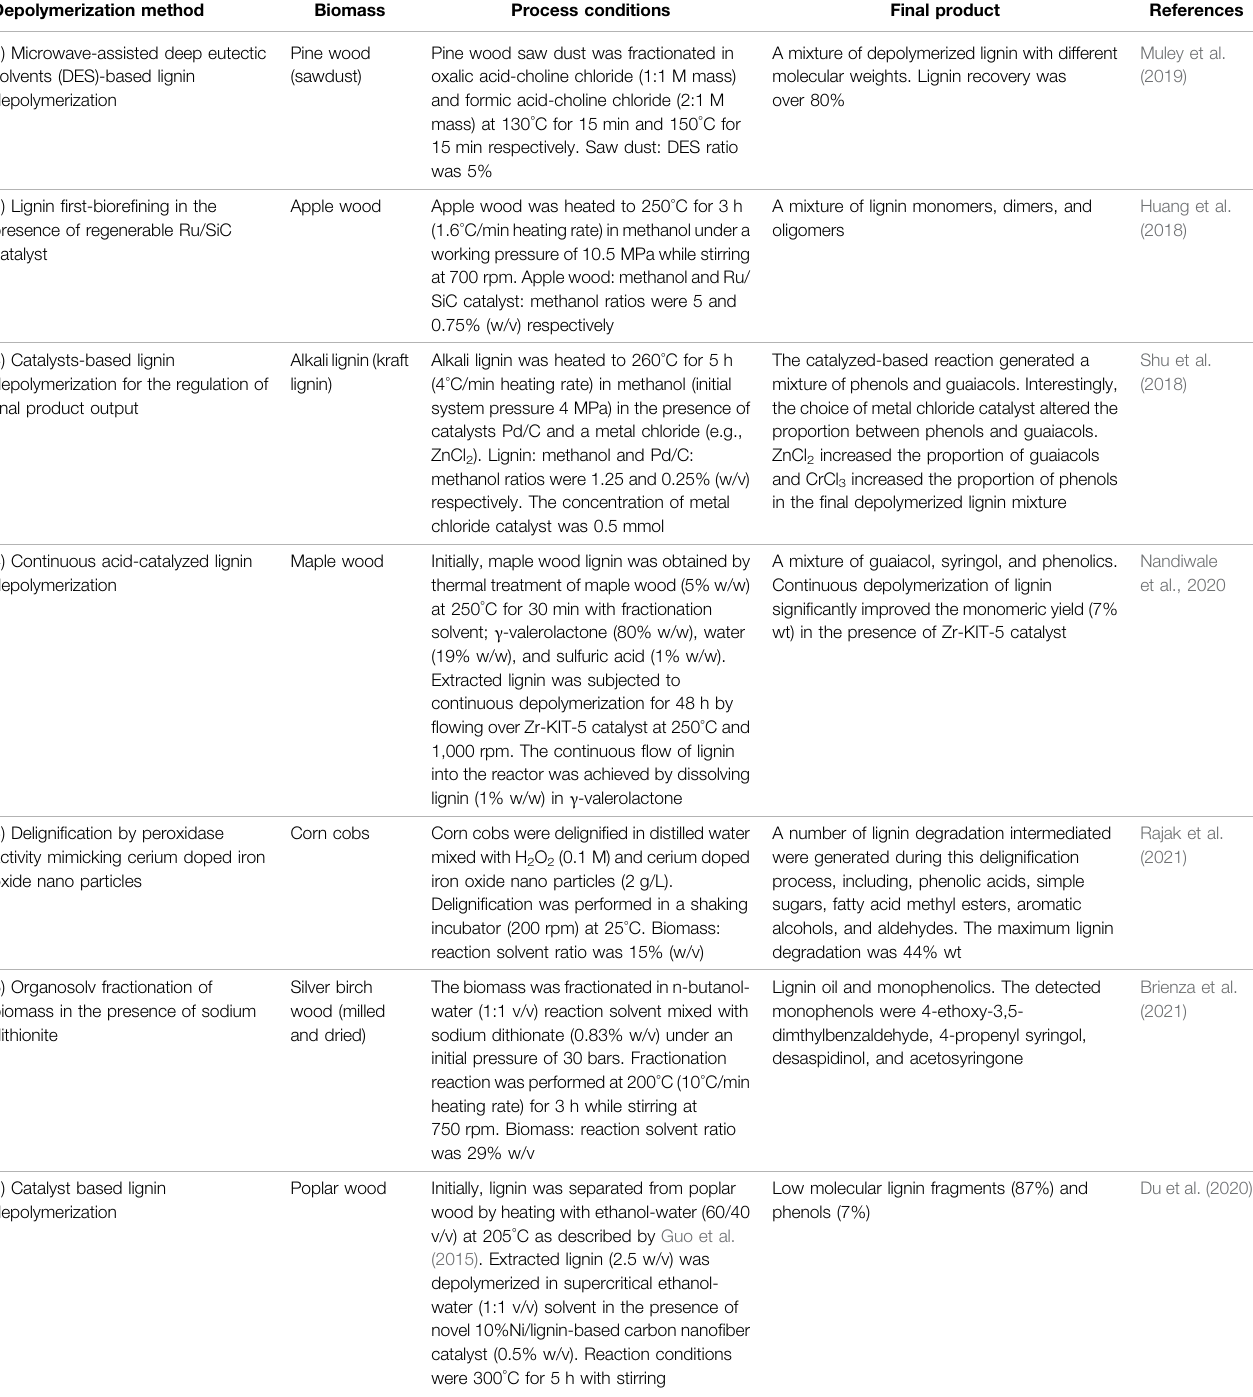
TABLE 1 | Recent approaches to increase biomass deligni fi cation ef fi ciency and generate target end products. Depolymerization